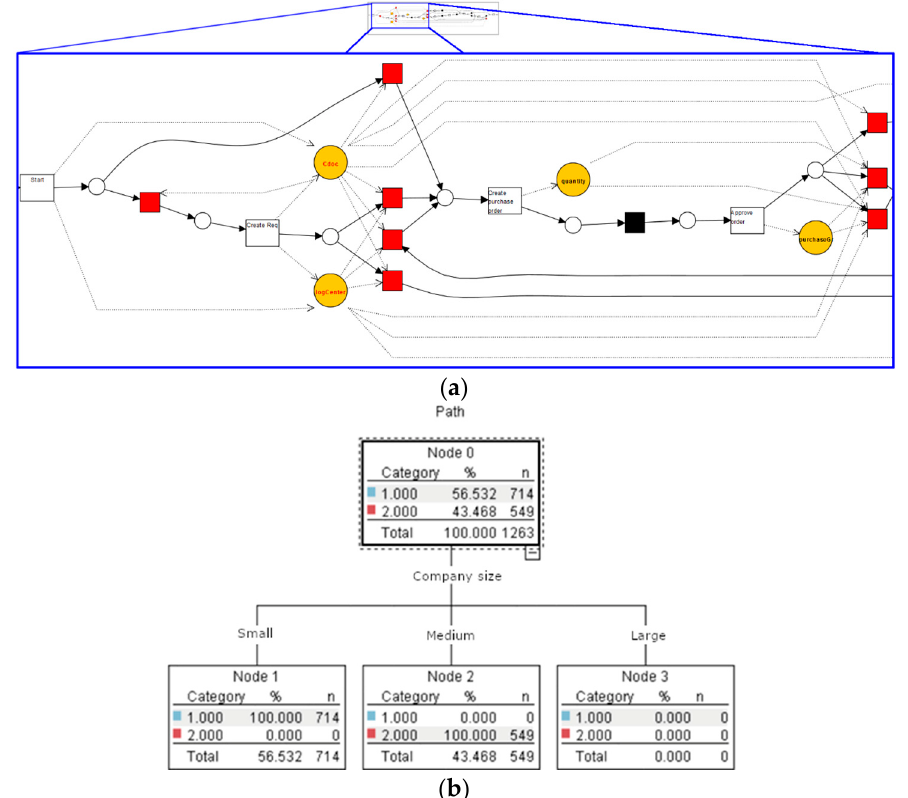
Figure 7. Two examples of combined data-oriented and process-oriented analytics. ( a ) Discovered model with decision points using ProM; ( b ) Decision tree classifier for a decision point split by company size.